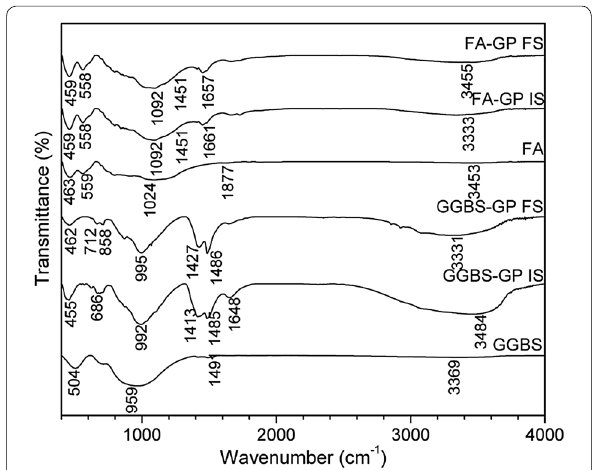
Fig. 3 FTIR spectra of raw materials and geopolymers at setting